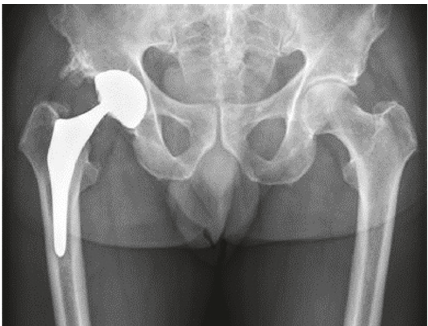
Figure 1: AP radiograph demonstrating eccentric positioning of the femoral head component of the right total hip arthroplasty without evidence for subsidence of the stem and loosening of the components.